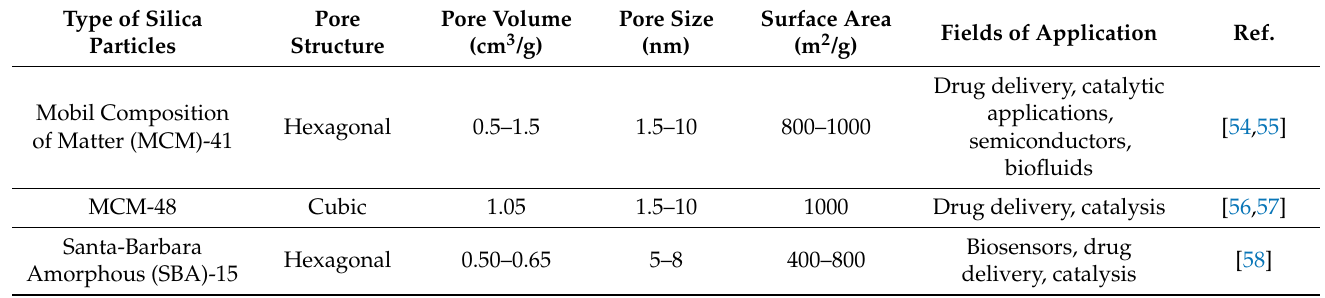
Table 3. Different types of